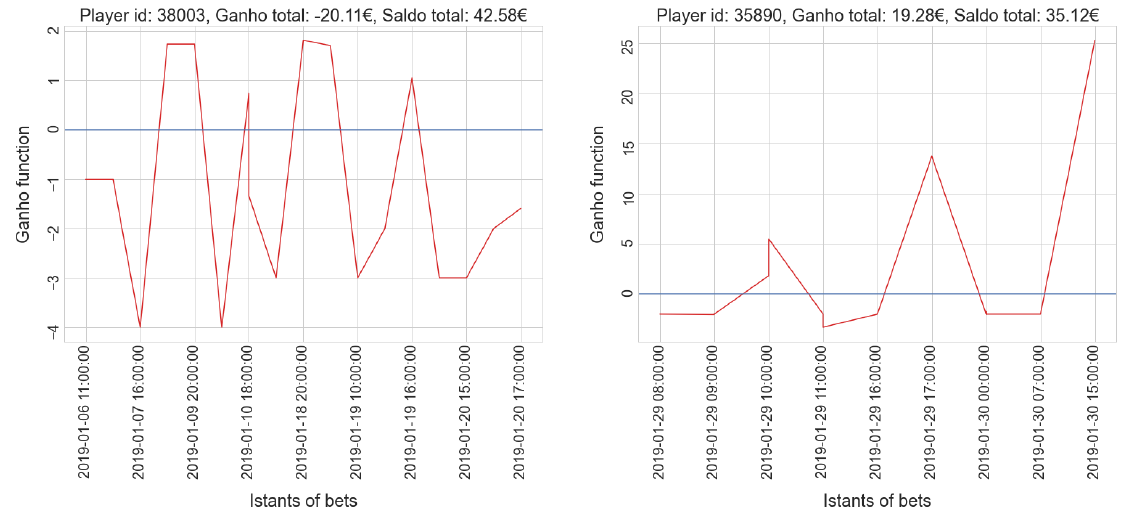
Figure 9. Time series plot of two players in Cluster